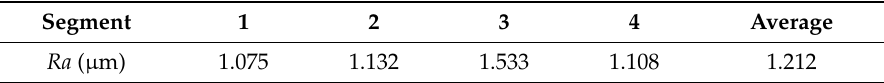
Table 6. Roughness Ra in the different segments of the WEDM cam .